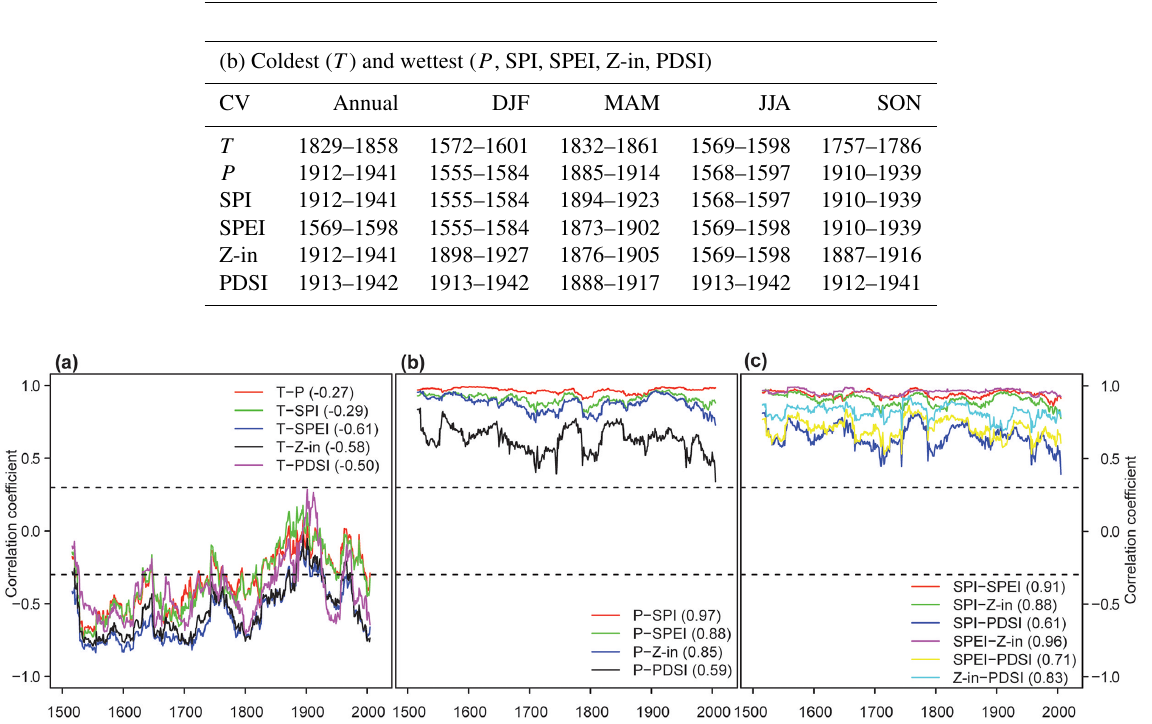
differed from the corresponding entire 520-year means only for the wettest and driest SPI in JJA and for the wettest SPI and SPEI in